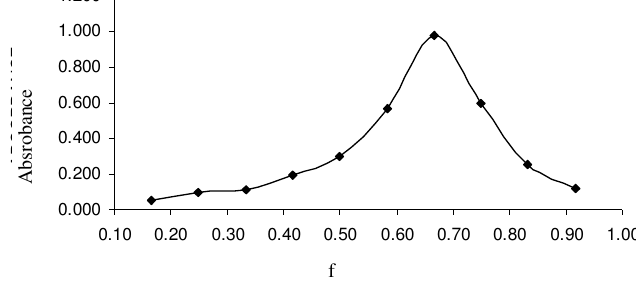
Figure 1. Job’s method (Cd(II)-HBBrPT Complex).